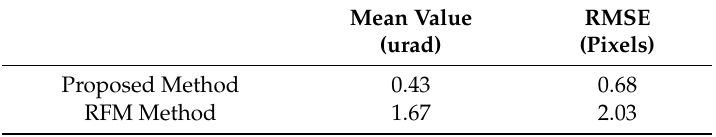
Table 1. Calibration results of the two methods using 50 RCPs in a typical